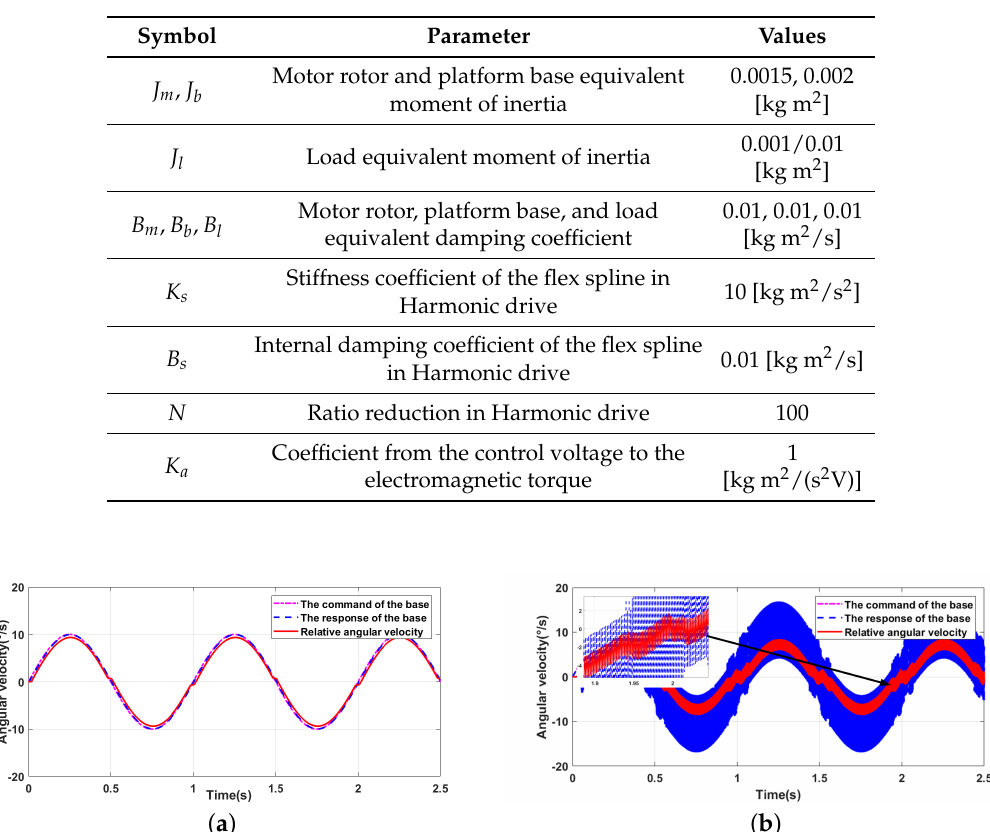
Table 1. Numerical analysis parameters.